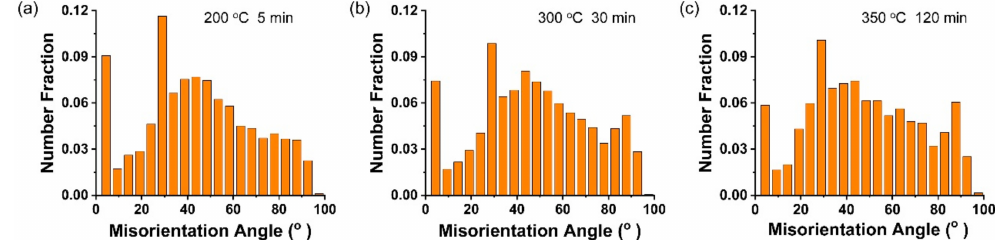
Figure 8. Misorientation angle distributions for annealed Mg wires. ( a ) 200 ◦ C / 5 min; ( b ) 300 ◦ C / 30 min; ( c ) 350 ◦ C / 120